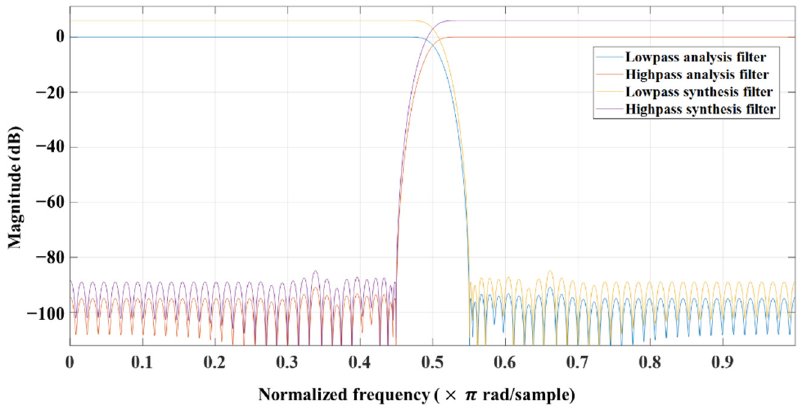
Figure 4. Block diagram of the encoder structure of the proposed method.